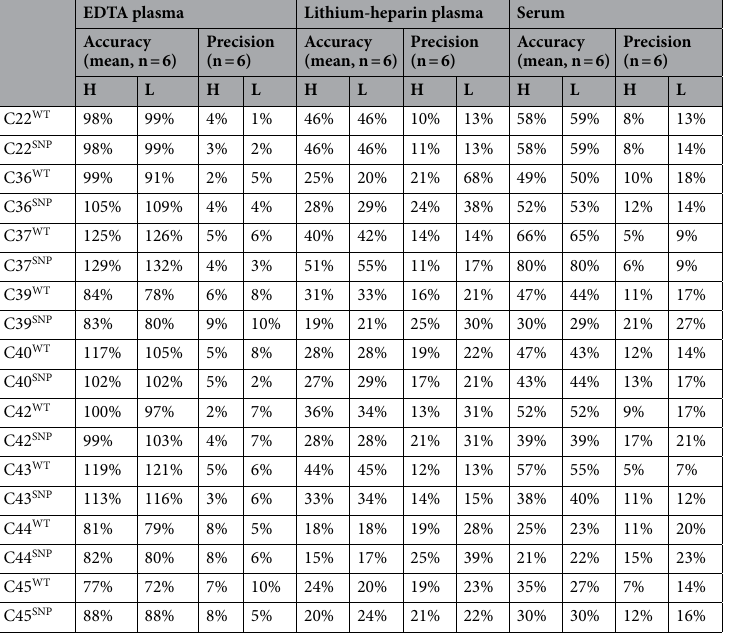
Table 3. Recovery rates of spiked CAAP concentrations in different biological matrices. Accuracies and precisions are shown as mean of six voluntary donors. H: high CAAPs concentration; L: low CAAPs concentration.